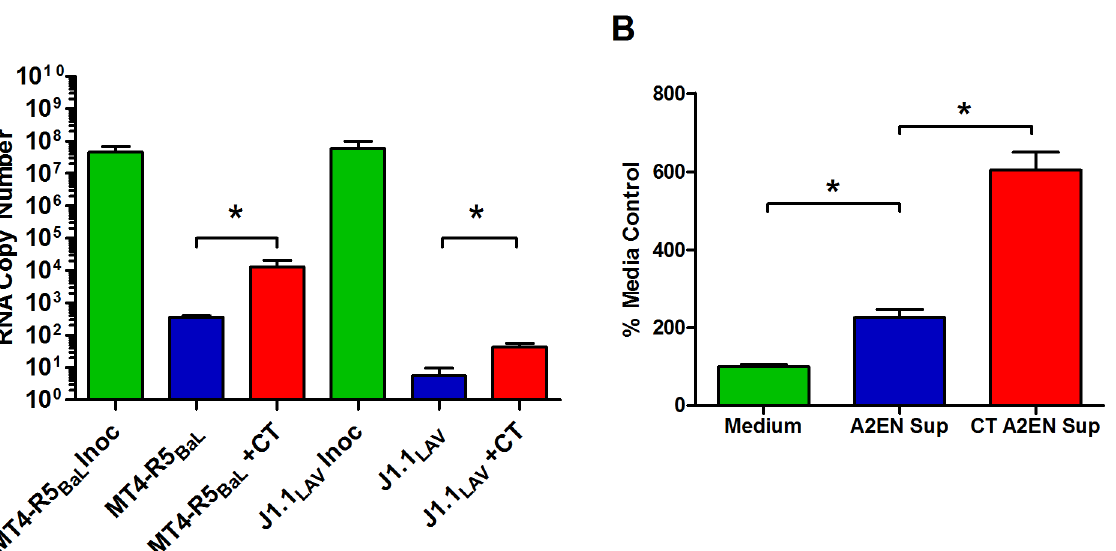
Fig 2. Cell-associated HIV crosses the A2EN epithelial barrier and is enhanced by CT infection. A2EN cells were infected with CT serovar D ( > 95% infection rate) for 72 h. 1 x 10 6 HIV BaL -infected MT4-R5 cells were added to the apical chambers of mock and CT-infected A2EN cells for 3 h at 37°C. ( A ) Viral RNA in basolateral supernatants from cell-associated HIV migration assays was quantitated using real-time PCR. Bars represent the mean RNA copies ± SD. ( B ) Basolateral supernatants collected in cell-associated HIV migration assays were incubated with uninfected MT4-R5 cells for 3 d. Supernatants from exposed MT4-R5 cells were then assayed for infectious virus using TZM-bl cells. Controls included TZM-bl cells incubated with an equivalent volume of epithelial cell medium. Data is expressed as a percentage of the mean RLU obtained for the medium alone controls. Bars represent the mean percentages ± SD. Results shown are representative of 4 separate experiments, each performed in quadruplicate. * p < 0.05.